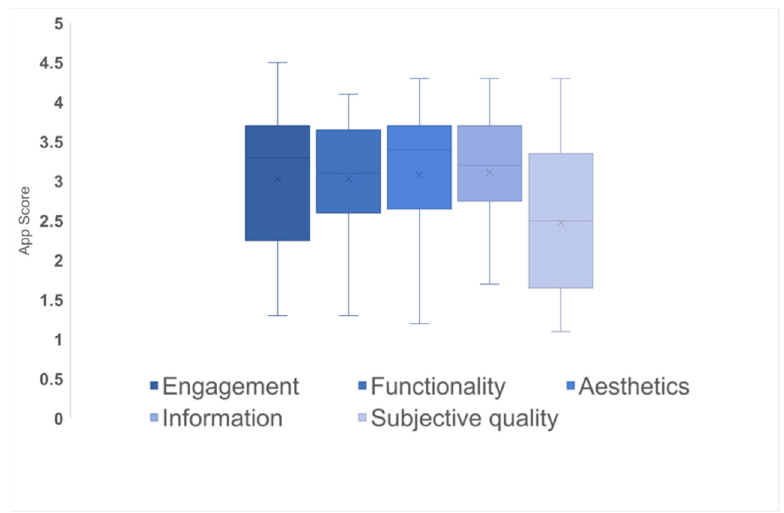
Figure 2. App scores according to Mobile App Rating Scale (MARS) dimensions.